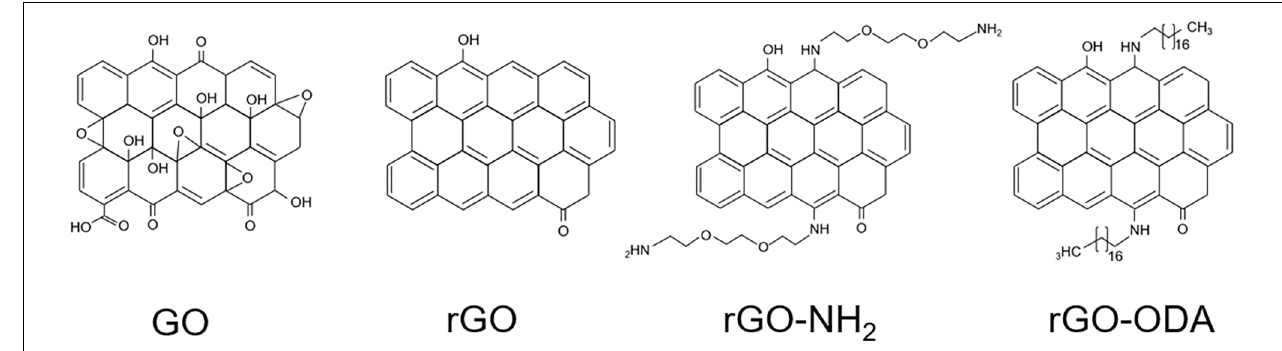
FIGURE 1 | Model structures of GO-based materials used in this